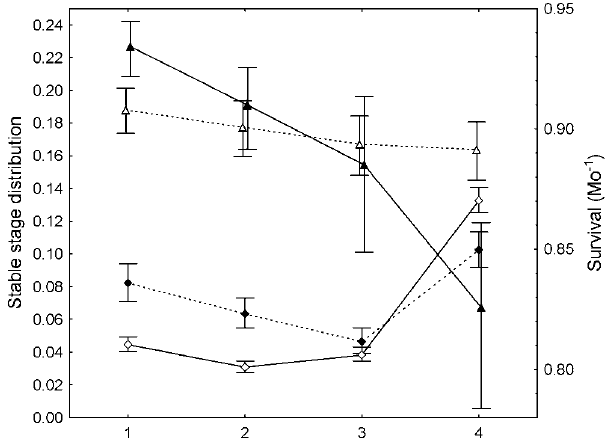
Figure 2. Stable stage distributions (diamonds; 6 95% CI) and survival (triangles; 6 95% CI) for the Isolated tributary (closed symbols) and for the summed size stages across locations in the Open system (open symbols). Stage 0 data are omitted for clarity.